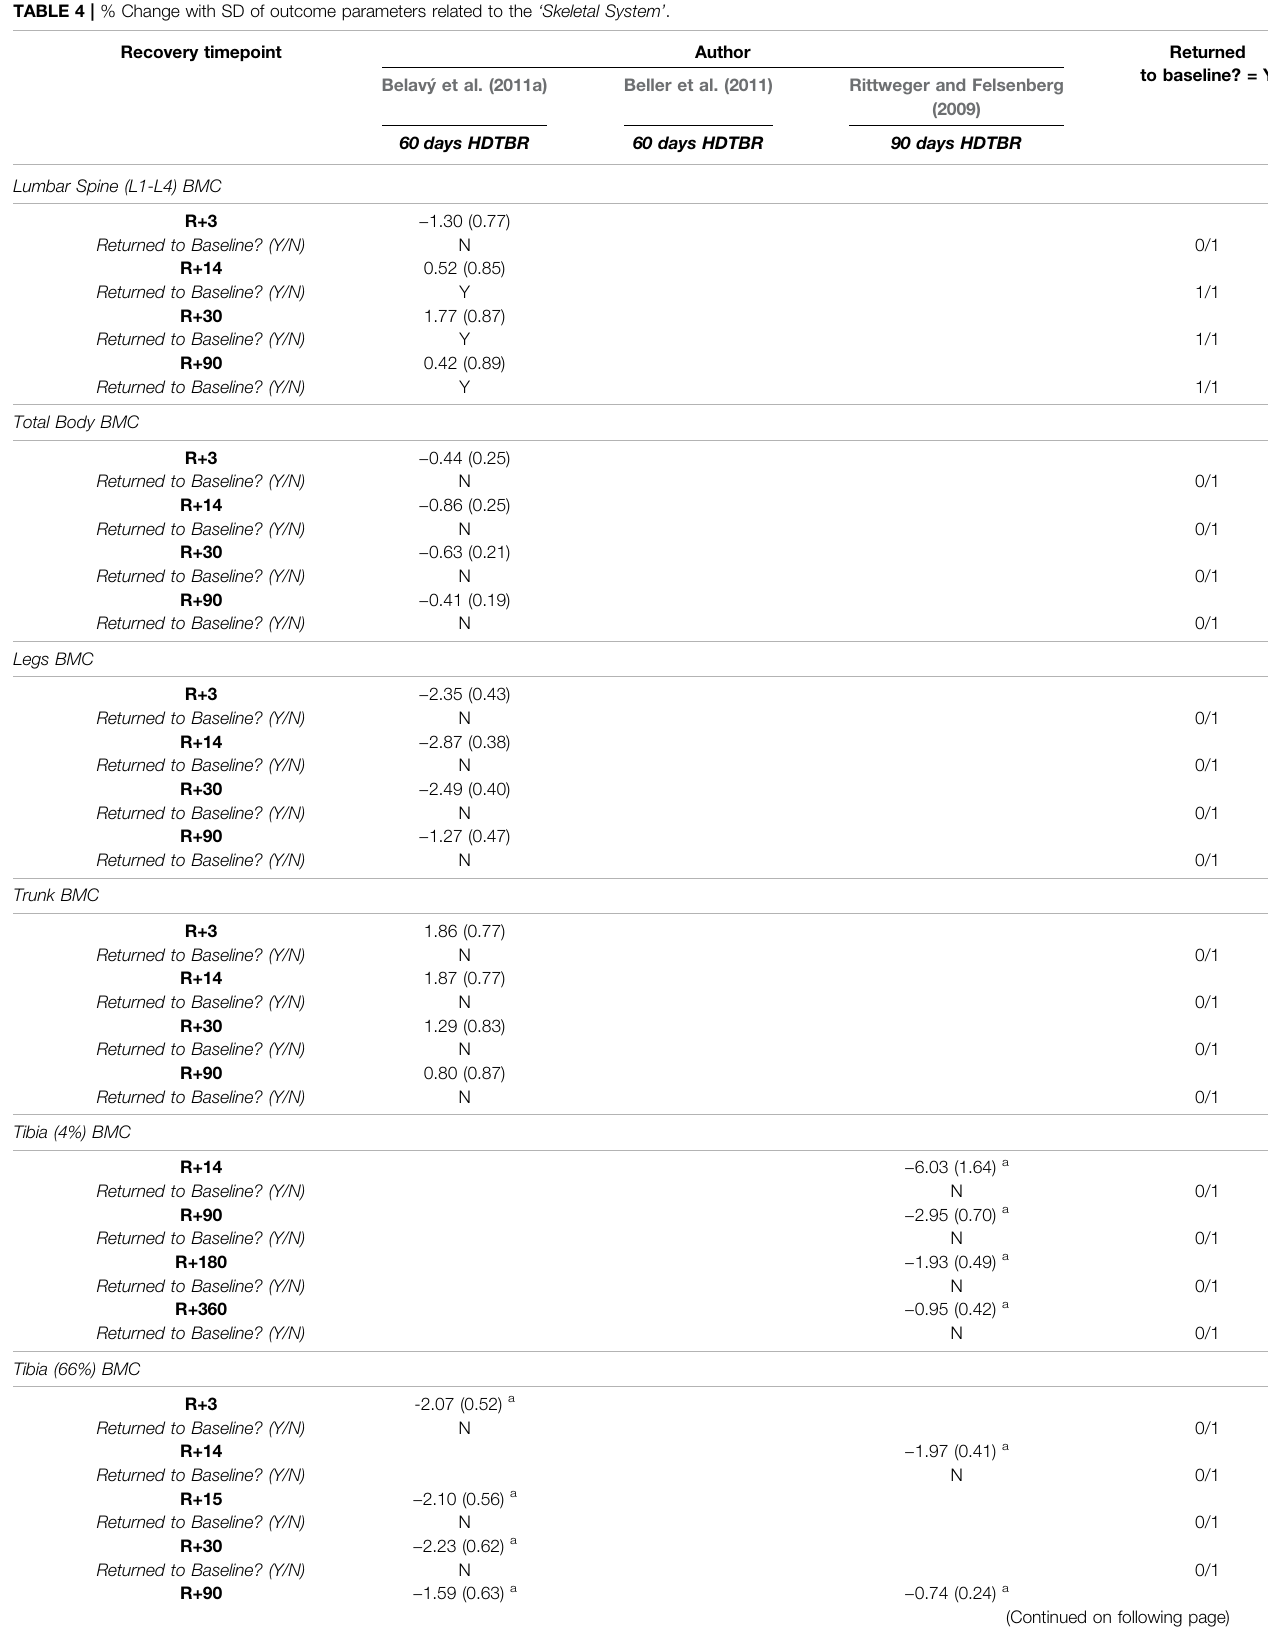
TABLE 4 | % Change with SD of outcome parameters related to the ‘ Skeletal System ’ . Recovery